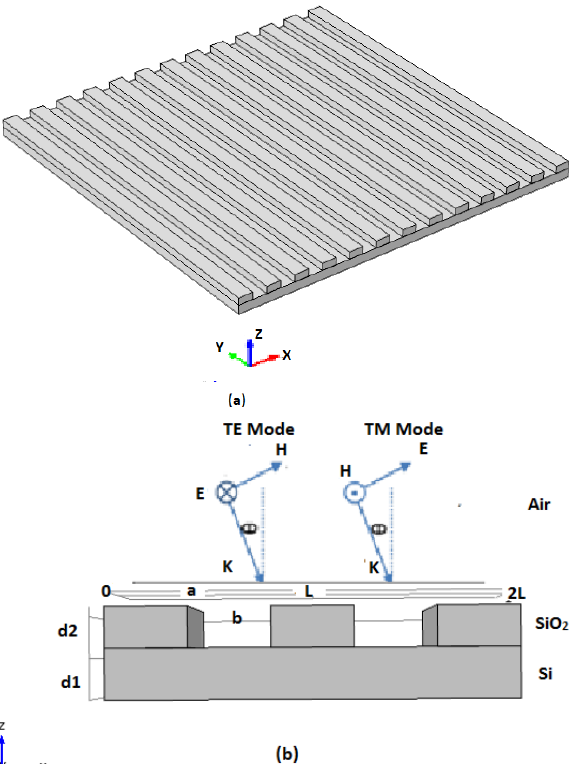
Figure 17. a) 3D schematic for the 1D grating strucures. (b) X-Z cross section for 1D grating structure